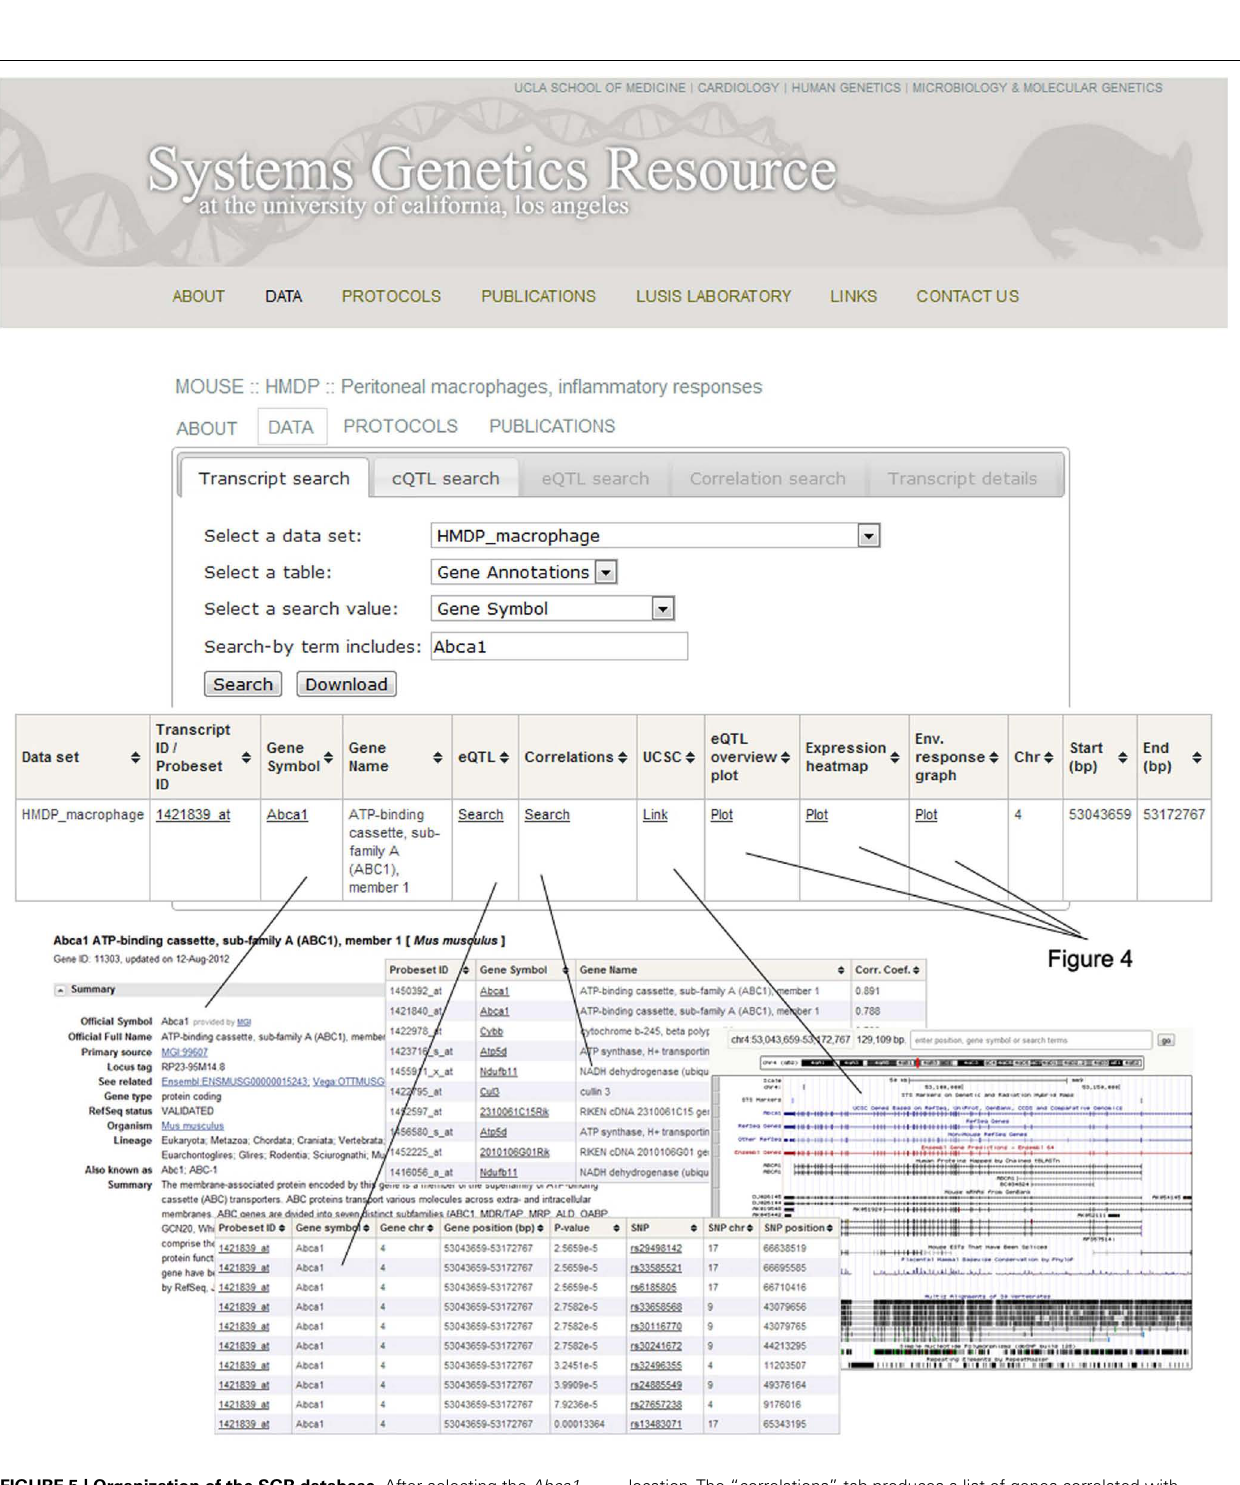
FIGURE 5 | Organization of the SGR database . After selecting the Abca1 gene in the HMDP macrophages dataset, a window will pop up with several options to help guide the researcher through the available SGR data and general information for that particular gene. For example, clicking on the “Gene symbol” tab links to NCBI (http://www.ncbi.nlm.nih.gov/) and the “UCSC” tab links to the UCSC genome browser (http://genome.ucsc.edu/). These sites provide various functional details on the gene as well as its